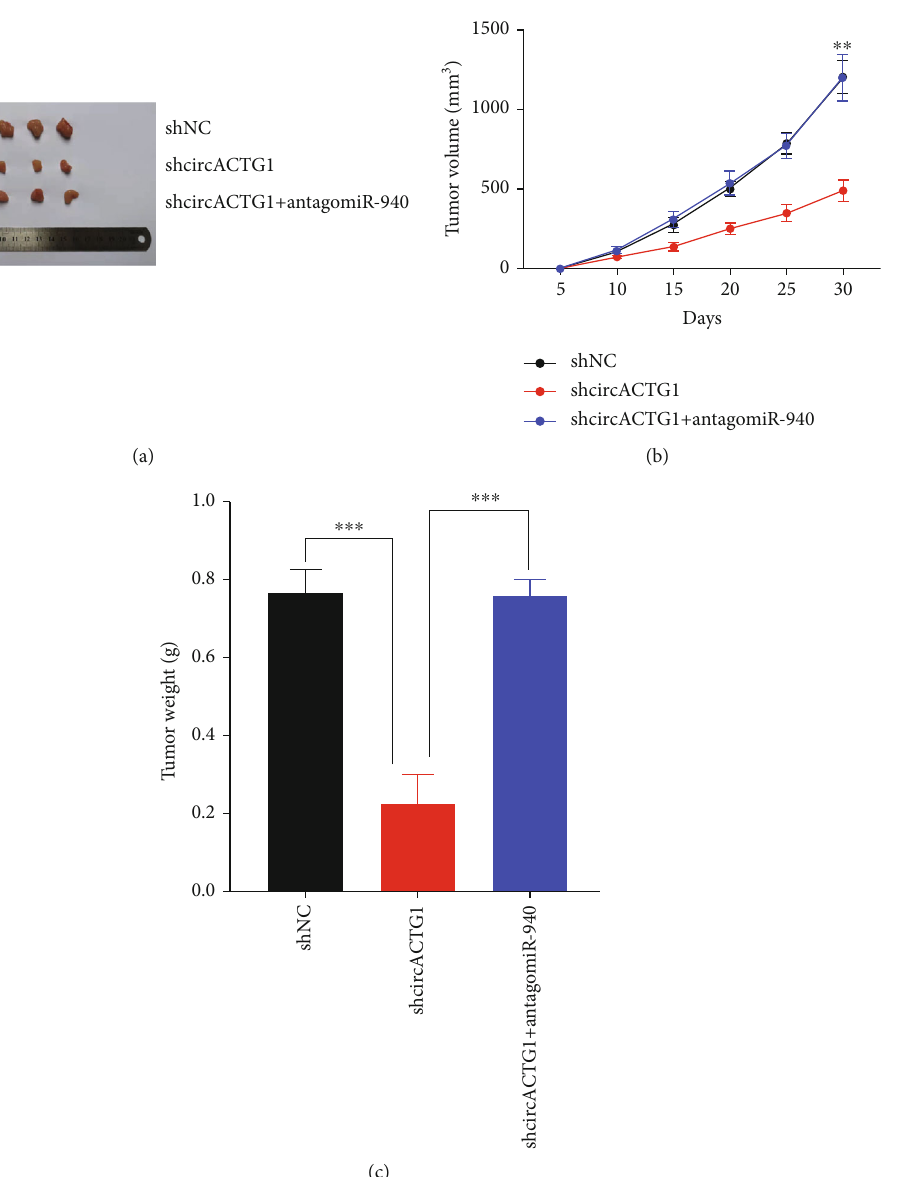
Figure 6: circACTG1 promoted tumorigenicity by targeting miR-940 in vivo. (a) 97H cells with circACTG1 knockdown (shcircACTG1) or normal control (shNC) were injected into the left and right dorsal fl anks of nude mice. (b and c) Tumor size (b) and weight (c) were measured after 30